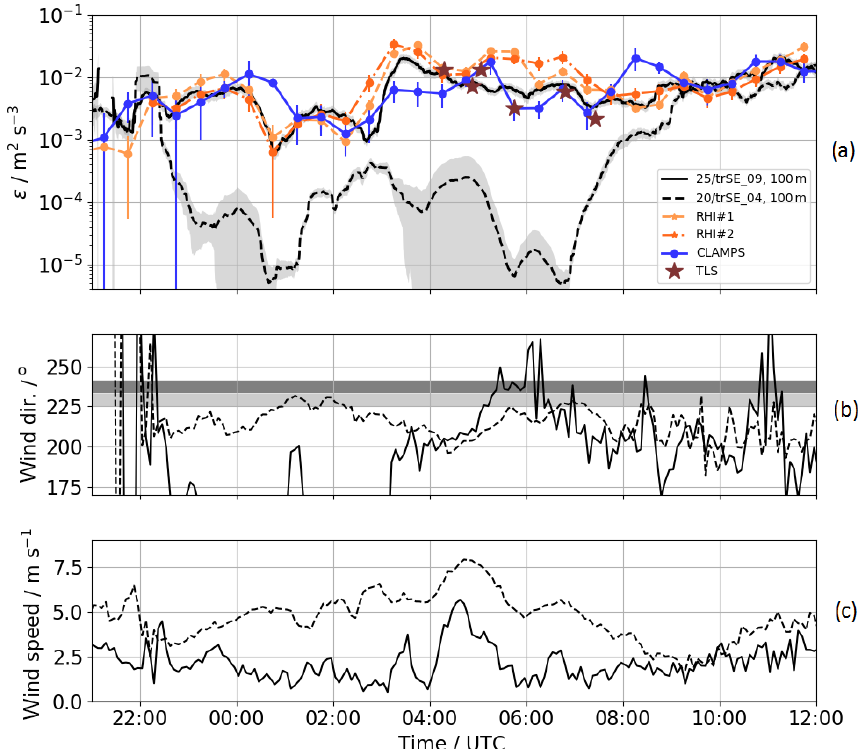
Figure 12. Comparison of ε as measured by the RHI scans, the vertical stare measurements, the TLS, and two reference sonic anemometers from 13 to 14 June 2017, 21:00–12:00UTC (a) . Panel (b) shows the wind direction and panel (c) the wind speed measured by sonic anemometers at the 100m level over the ridge and in the valley. The shaded areas in (b) give the wind direction regions in which CLAMPS (light gray) and RHI#1 and #2 (dark gray) are in the line of sight of the WT rotor